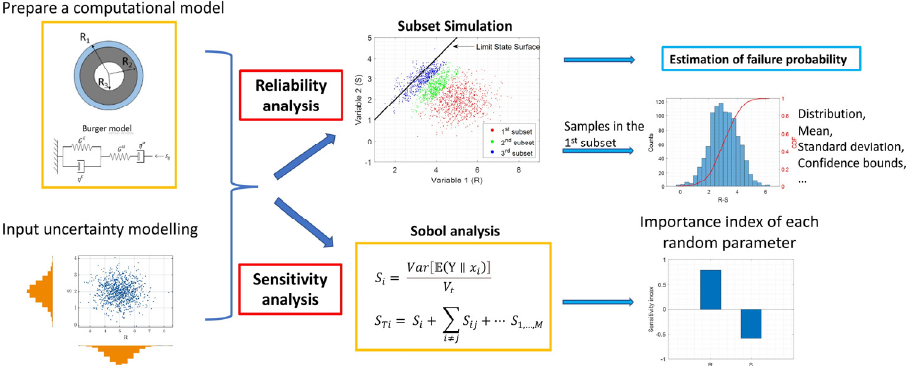
Figure 4. Flow chart of the probabilistic analysis procedure introduced in this paper (example of two random variables).